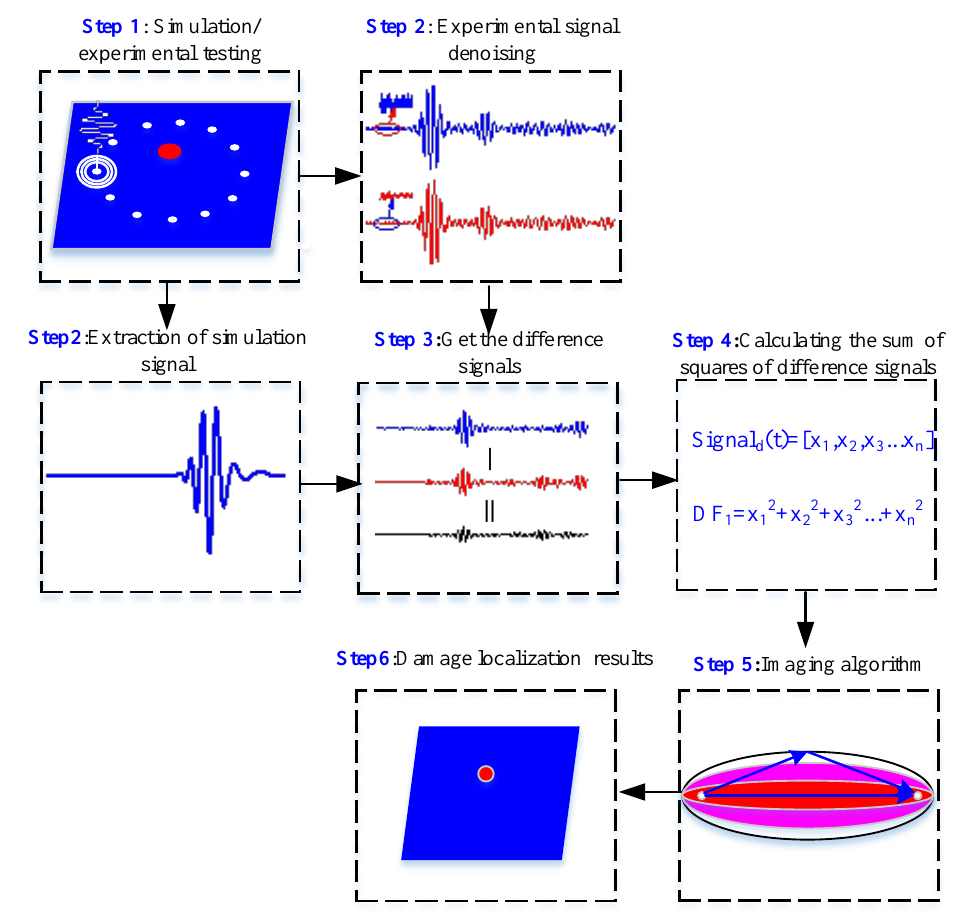
Figure 3. Flow chart of composite damage imaging.